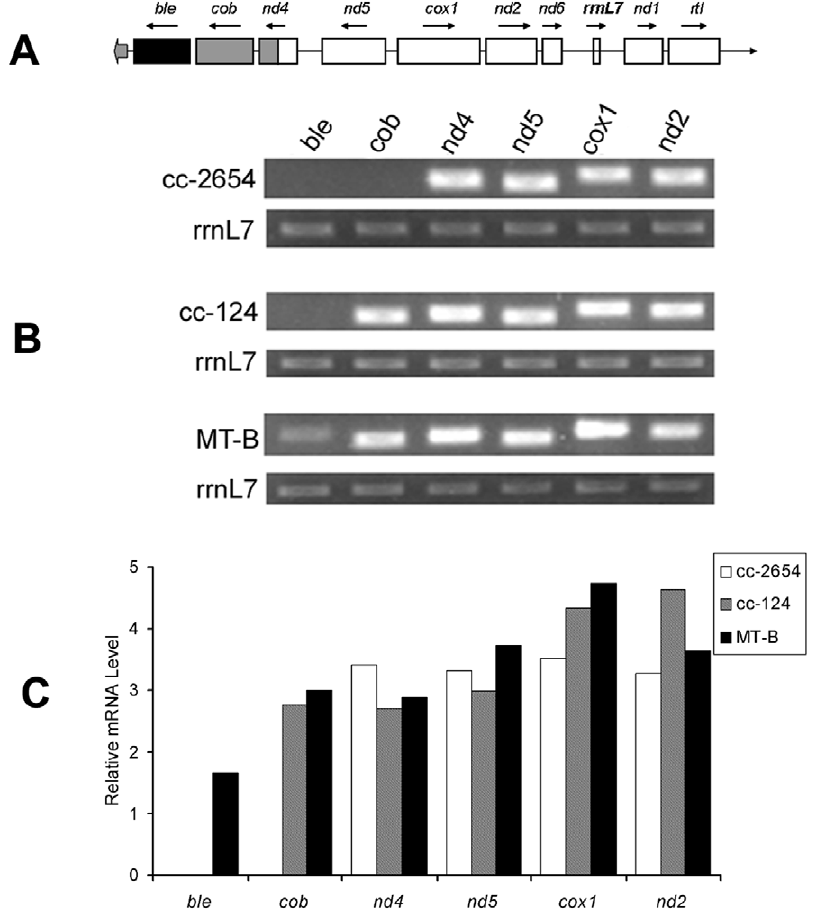
Figure 7. The expression levels of the Shble gene and the mitochondrial genes in transgenic MT-B. A: The gene organization of MT-B mitochondrial genome: B: RT-PCR results of Sh ble gene and the mitochondrial genes with rrnL7 as internal control; C: Relative mRNA levels analysis using BIO-RAD image software.